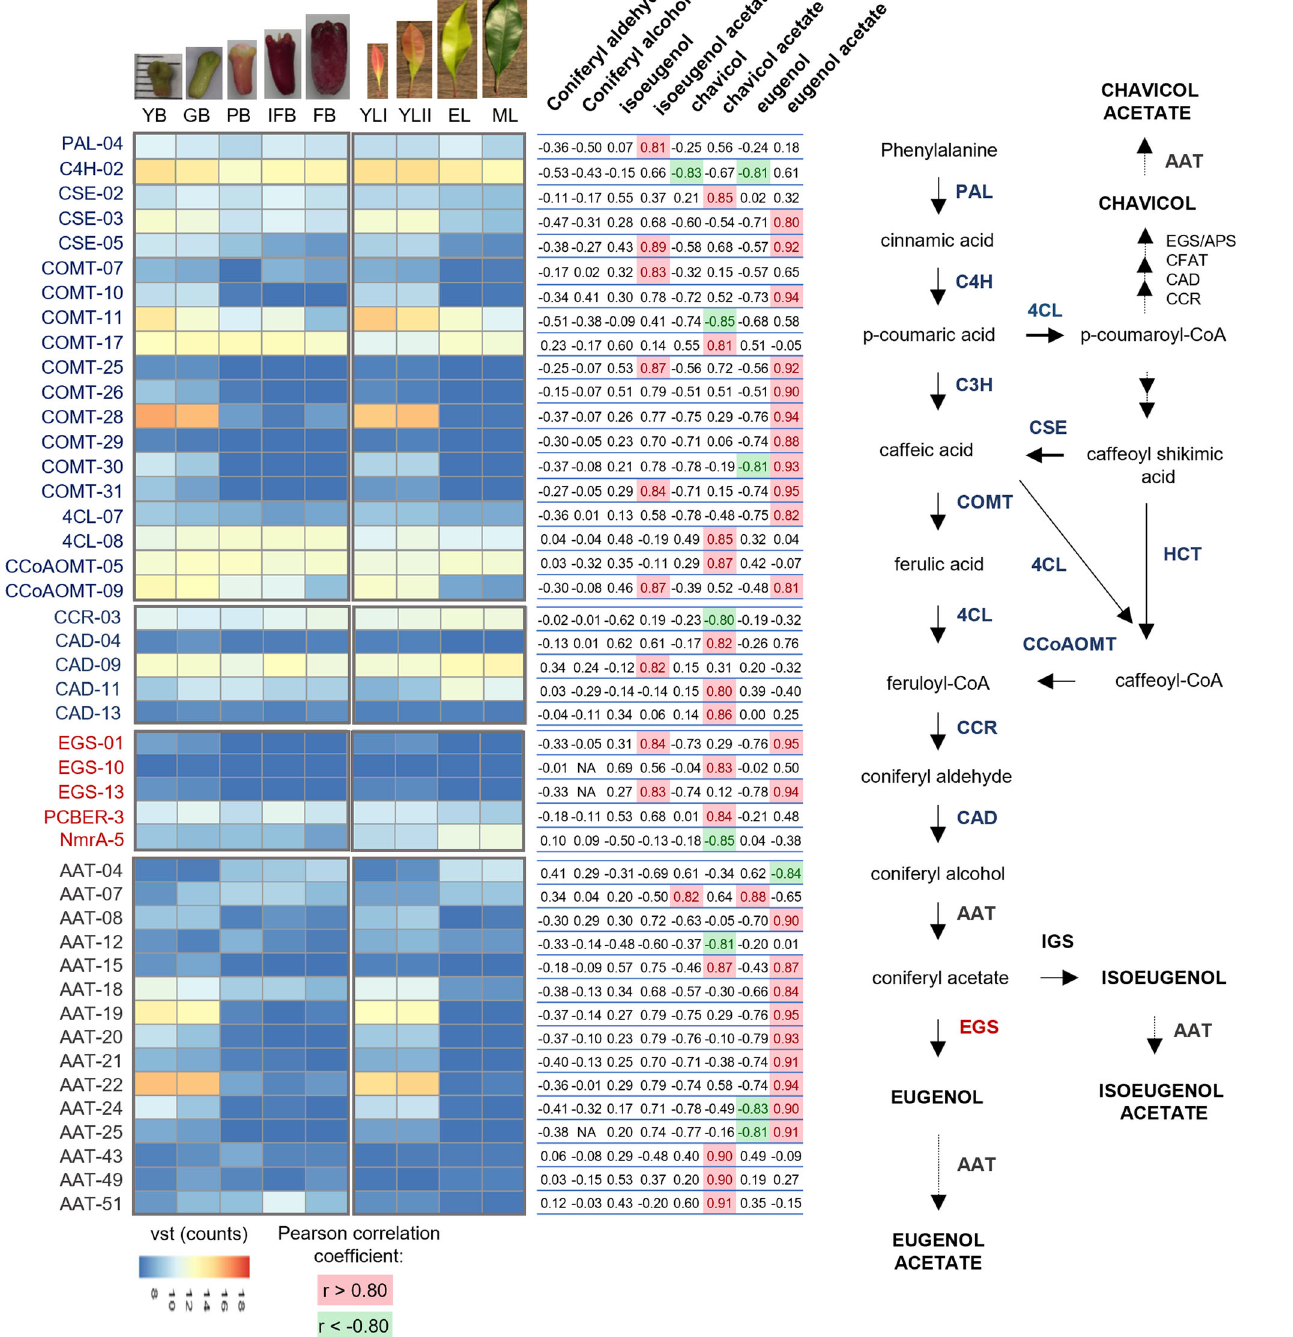
8 COMMUNICATIONS BIOLOGY| (2022) 5:684